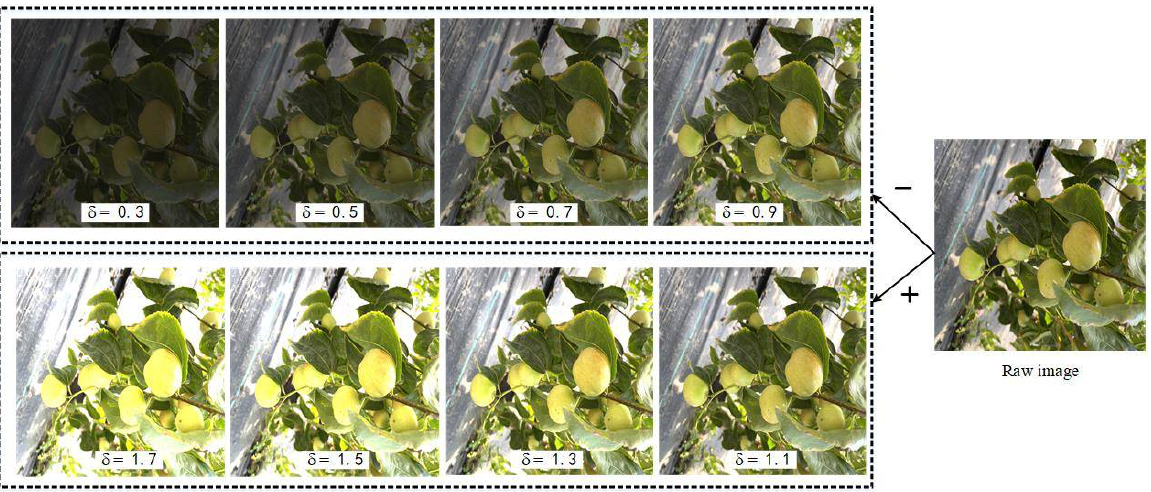
Figure 12. Test images under different illuminations.